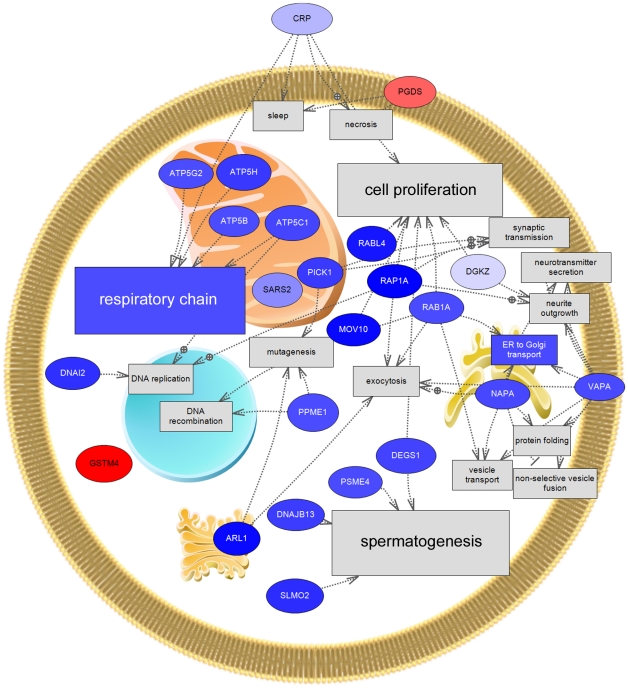
Pathway analysis of differentially regulated genes from conch testis microarray study.Pathway Studio (Ariadne Genomics) was used to find all shortest paths between human homologues of genes falling under significantly enriched GO Biological Processes in the testis. Red color represents up-regulation nearshore (NS); blue color represents down-regulation NS. Genes: ARL1, zgc:92883 (ADP-ribosylation factor-like 1); ATP5B, ATP synthase, H+ transporting, mitochondrial F1 complex, beta polypeptide; ATP5C1, ATP synthase, H+ transporting, mitochondrial F1 complex, gamma polypeptide 1; ATP5G2, ATP synthase, H+ transporting, mitochondrial F0 complex, subunit C2 (subunit 9); ATP5H, ATP synthase, H+ transporting, mitochondrial F0 complex, subunit d; CRP, si:ch211-234p6.13 (Danio rerio hypothetical protein); DEGS1, im:6909319 (degenerative spermatocyte homolog, lipid desaturase); DGKZ, hypothetical LOC571856 (similar to diacylglycerol kinase, iota); DNAI2, dynein, axonemal, intermediate chain 2; DNAJB13, DnaJ (Hsp40) related, subfamily B, member 13; GSTM4, glutathione S-transferase mu 4; MOV10, si:dkeyp-38g6.3 (Moloney leukemia virus 10); NAPA, N-ethylmaleimide sensitive fusion protein attachment protein alpha; PGDS, prostaglandin D2 synthase, hematopoietic; PICK1, hypothetical protein LOC791503; PPME1, zgc:56239 (protein phosphatase methylesterase 1); PSME4, hypothetical LOC561538 (proteasome (prosome, macropain) activator subunit 4); RAB1A, RAB1A member RAS oncogene family; RABL4, RAB, member of RAS oncogene family-like 4; RAP1A, RAP1A, member of RAS oncogene family; SARS2, seryl-tRNA synthetase 2, mitochondrial; SLMO2, slowmo homolog 2 (Drosophila) (similer to kiser); VAPA (VAMP (vesicle-associated membrane protein)-associated protein A, 33 kDa. Organelles, clockwise from top center: mitochondrion, endoplasmic reticulum, Golgi complex, nucleus.